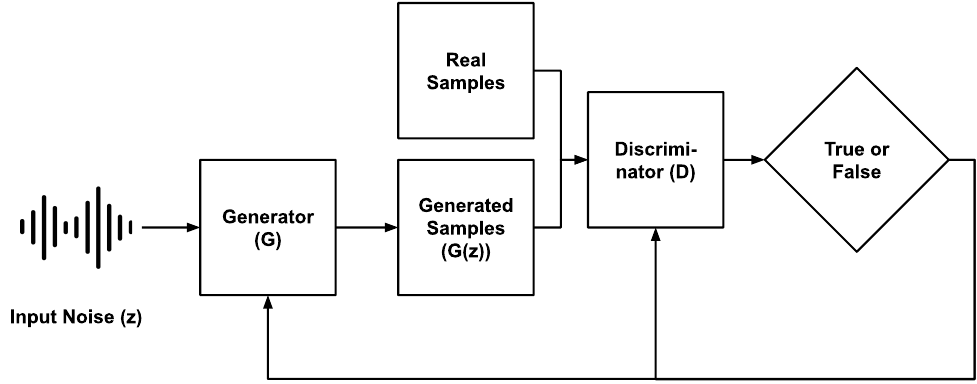
Figure 3. Overview of the GAN framework, consisting of two models, the generator (G) and discriminator (D). The training of both models happens simultaneously. The G network receives noise as input and generates synthetic data samples. These synthetic samples are used, together with actual samples, to train D, which in turn provides the feedback necessary to train G. The idea is that the training will stop when D cannot differentiate between real and synthetic samples anymore. Note that G never sees any actual samples whatsoever and is trained only through the feedback it receives from